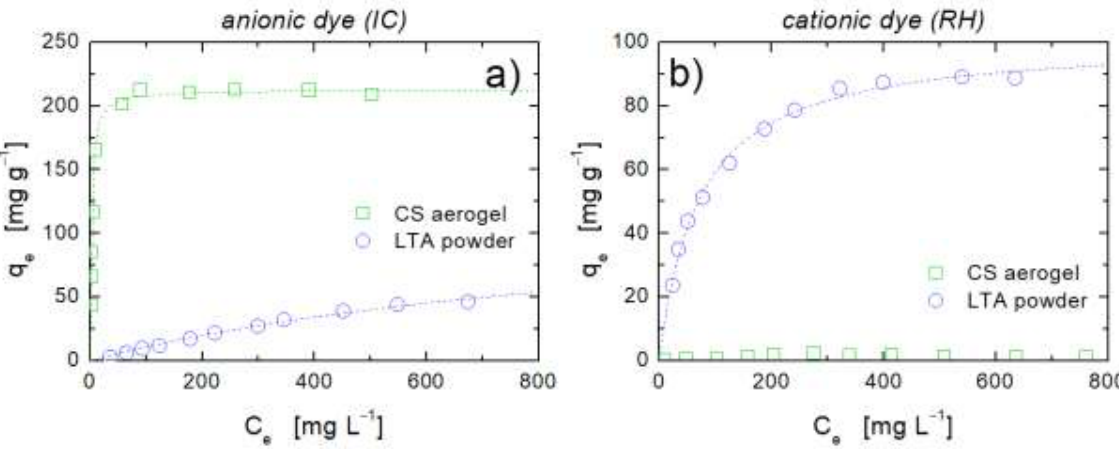
Figure 5. Adsorption isotherms at 25 °C of ( a ) anionic dye IC and ( b ) cationic dye RH for pristine CS aerogels (squares) and LTA powder (circles). Dashed lines represent best fitting with the Langmuir model (Equation (1)).